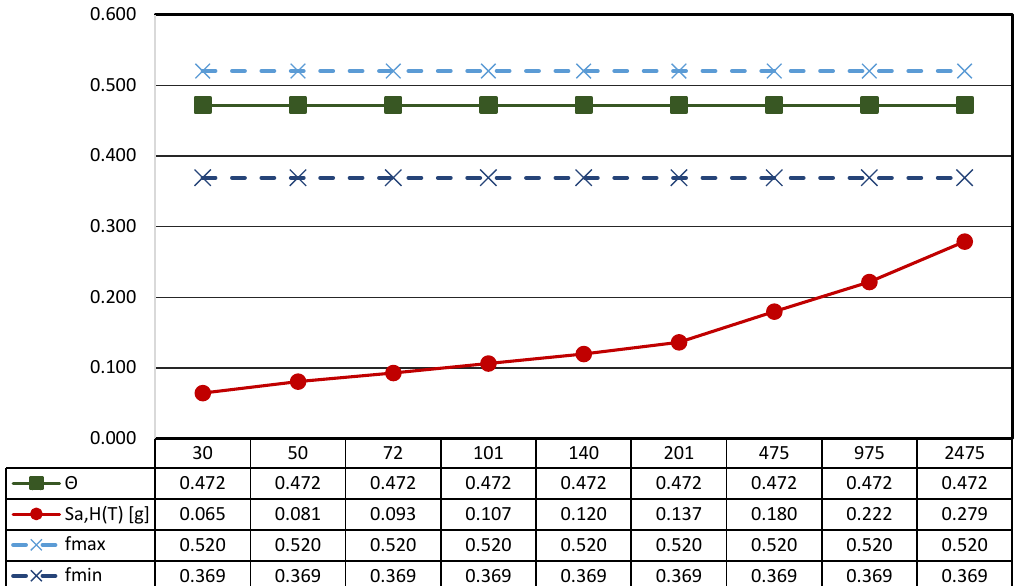
Figure 12. Results of the seismic performance assessment of the Mater Matuta under horizontal shaking only.